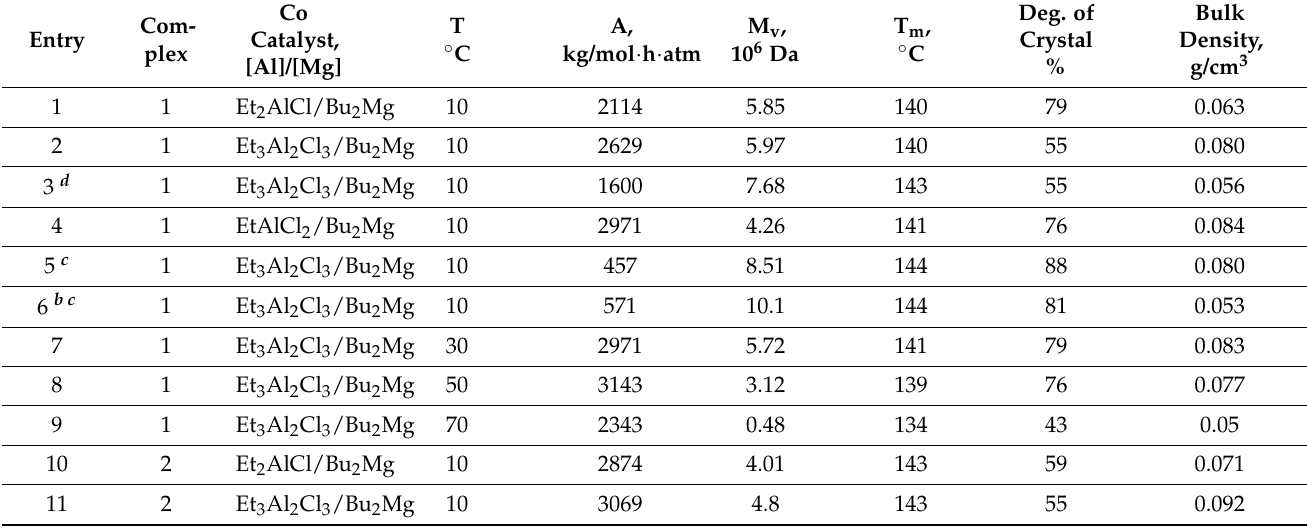
Table 1. Ethylene polymerization by complexes 1–4 a